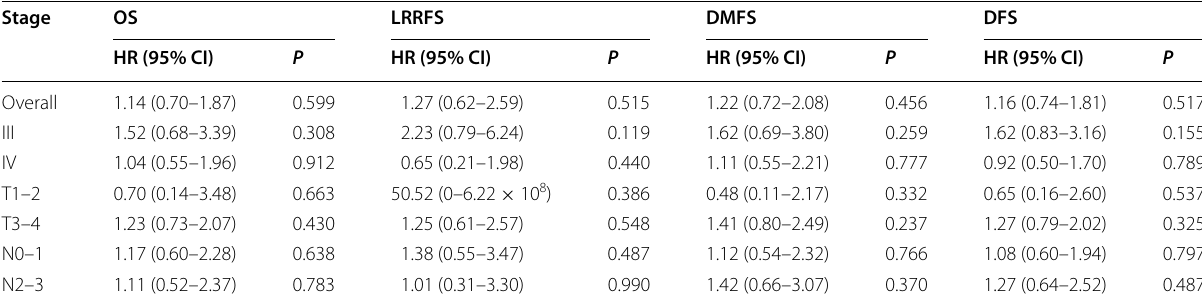
Table 4 Subset analyses on tumor control in patients with locoregionally advanced NPC treated by NAC plus IMRT vs. CCRT plus AC